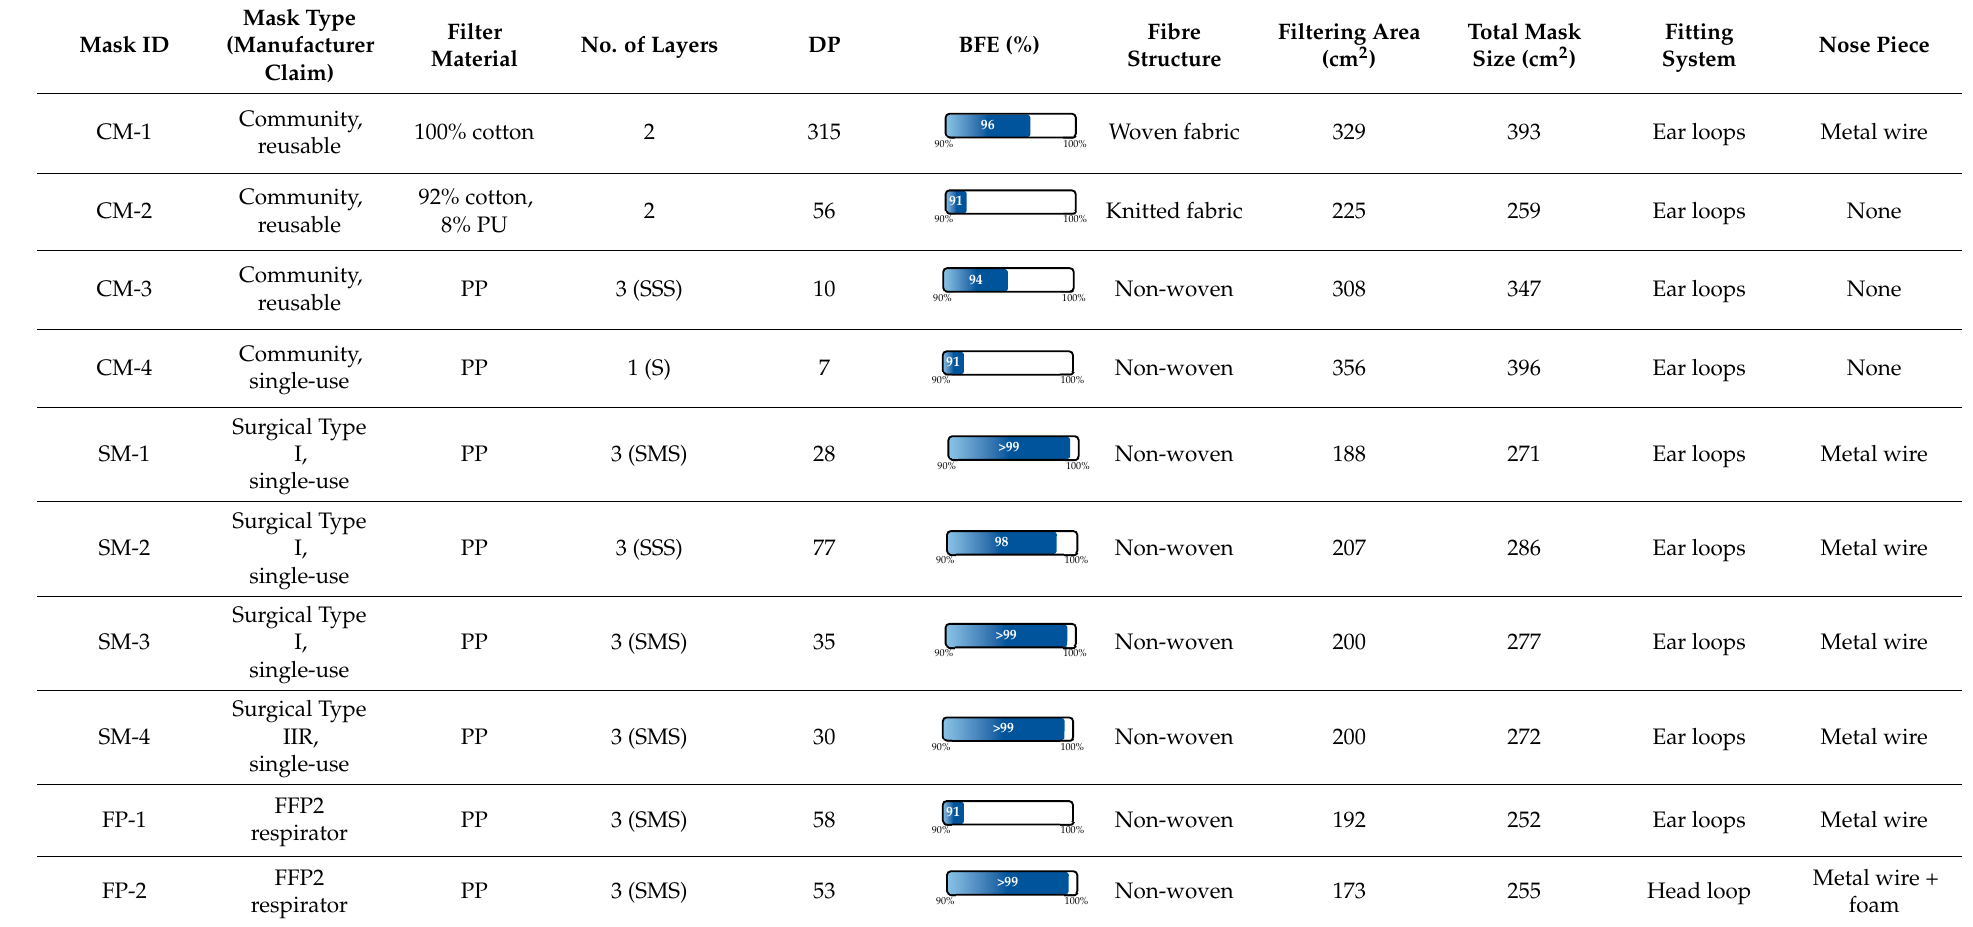
Table 2. Details of facemask specifications used in Chiera et al. study [31].